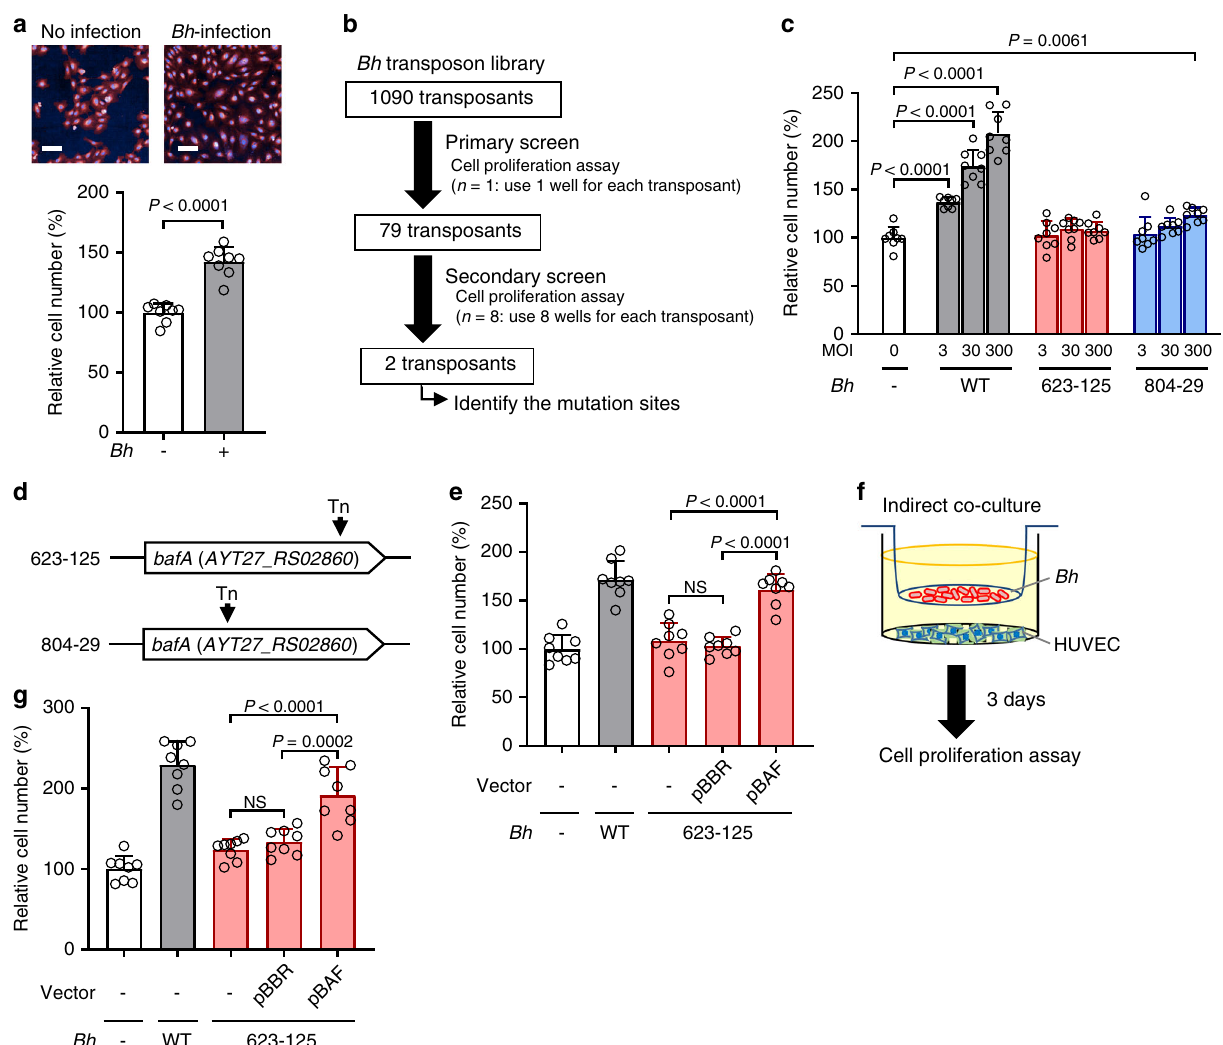
Fig. 1 Identi fi cation of B. henselae gene essential in promoting vascular endothelial cell proliferation. a B. henselae ( Bh ) promotes vascular endothelial cell proliferation. Human umbilical vein endothelial cells (HUVECs) were co-cultured with or without Bh at multiplicity of infection (MOI) of 30 for 3 days. Fluorescence images stained with CellMask (red) and Hoechst 33342 (blue) are shown. Scale bar = 100 µ m (upper). The numbers of cells from the images were counted, and the values were normalized to the uninfected cells as 100% (lower). b Screening process for Bh transposants lacking cell proliferative ability. c Cell proliferative ability of Bh -WT and two transposants isolated from the screening. HUVECs were co-cultured with Bh cells (WT, 623-125, or 804-29) at MOI of 3, 30, or 300 for 3 days, and the relative cell numbers are shown. d Diagram of bafA ( AYT27_RS02860 ) in two transposants, showing the locations of transposon insertion in 623-125 (at base pair position 646,986 in the Bh genome; NCBI accession no. NC_005956.1) and 804-29 (at position 645,770). e Ectopic expression of bafA restores Bh -induced cell proliferation. HUVECs were co-cultured with WT or 623-125 transposants complemented with bafA expression plasmid pBAF. The transposants without vector and with empty vector (pBBR) were used as negative controls. After 3-day incubation, relative cell numbers were counted. f Schematic representation of indirect co-culture of Bh and HUVECs. g Bh cells with bafA promote cell proliferation without direct contact. HUVECs were co-cultured indirectly with or without indicated Bh strains. After 3-day incubation, cell numbers were calculated. Bars are colored based on the strain: white for no infection, gray for WT, red for 623-125 and blue for 804-29 ( a , c , e , g ). Data are mean ± s.d. ( n = 8 biological replicates). Statistical signi fi cance was determined using a two-tailed unpaired Student ’ s t test ( a ), one-way ANOVA with Dunnett ’ s multiple comparisons test ( c ), or with Tukey ’ s multiple comparisons test ( e , g ). ** P < 0.01; *** P < 0.001; NS not signi fi cant. All experiments were performed at least three times, and one of repeats is shown for each. Source data are provided as a Source Data fi indicate that BafA production in B. henselae speci fi cally increase the expression levels of angiogenesis-related genes in endothelial cells.